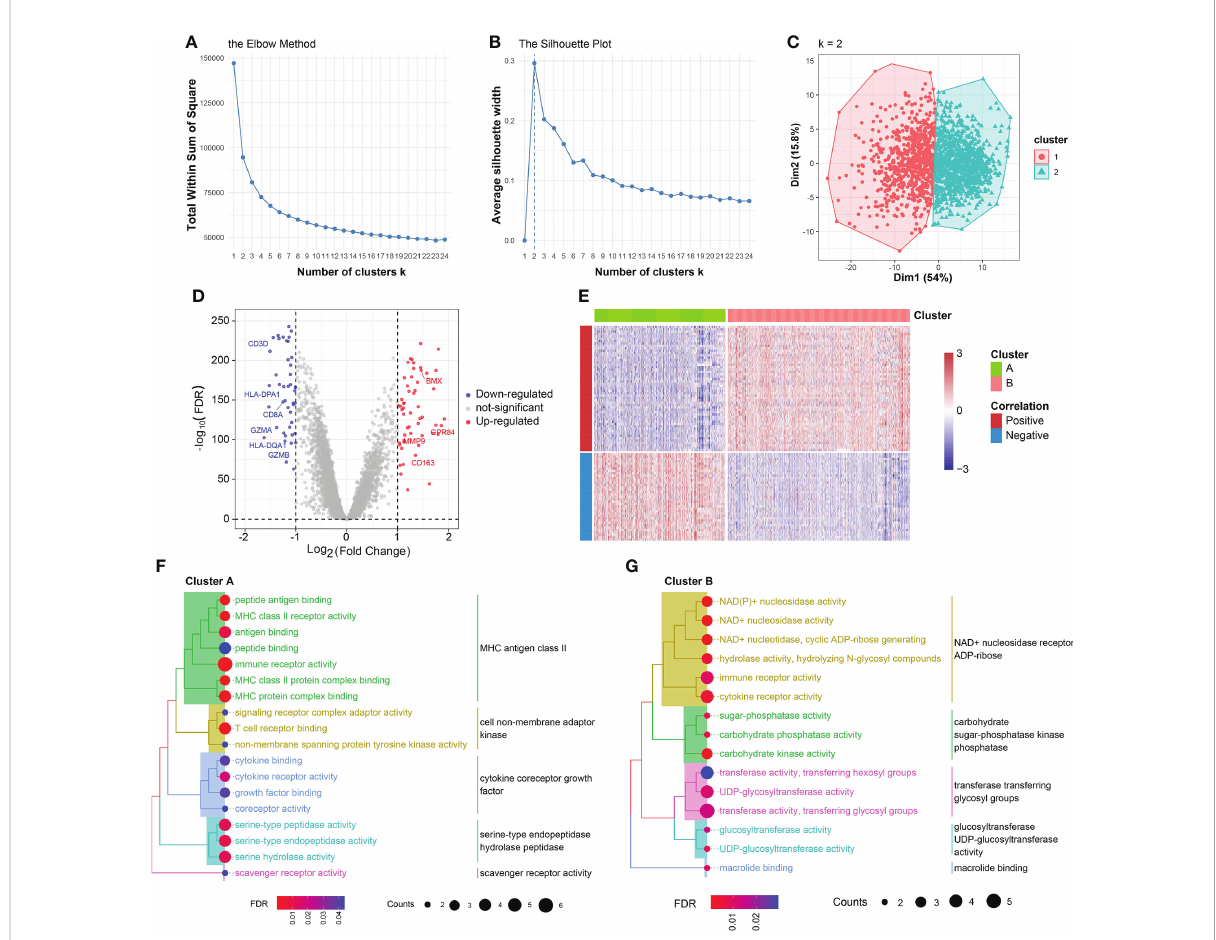
FIGURE 3 K-means clustering analysis and cluster annotation. (A) Total within sum of square (WSS) plotted against the number of clusters. The WSS dropped rapidly from 1 to 2 classes and slowly after k = 2. (B) Average silhouette width plotted against the number of clusters, demonstrating the 2-subclass was the ideal choice. (C) Scatter plot of distribution of sepsis samples in the two principal dimensions. (D) Volcano plot of DEGs of cluster B vs . cluster A. (E) Heatmap of DEGs between cluster A and cluster B. The expression values were normalized from -3 to 3. Color red represents relatively increased expression and color blue represents relatively deceased expression. (F) Gene Ontology (GO) analysis on DEGs overexpressed in cluster A. (G) Gene Ontology (GO) analysis on DEGs overexpressed in cluster